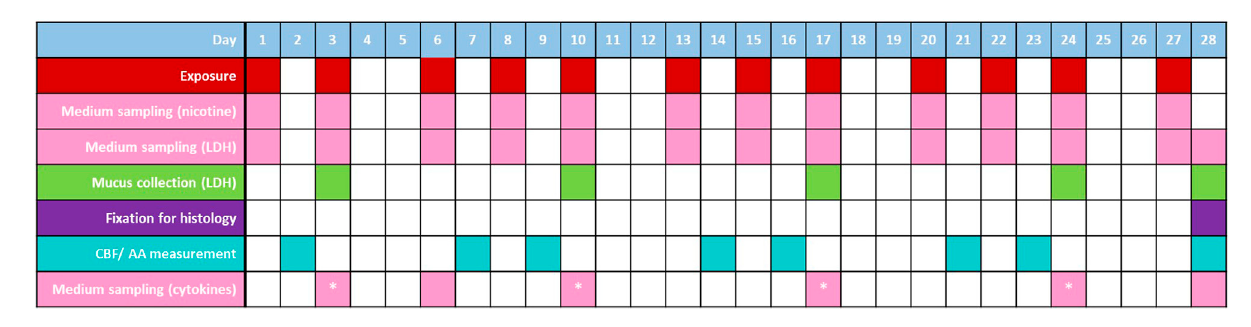
FIGURE 1 Exposure and sampling/measurement regimes for the 3D models over the experimental period. Samples of medium were taken (following exposures; prior to harvesting on day 28) and mucus (4 h prior to exposures) over the experimental period for LDH release measurement; medium was also sampled for cytokine analysis directly before exposure; on days denoted with *, samples were taken both directly before exposure and 4 h following exposure. Cilia beat frequency (CBF)/active area (AA) measurements were taken on days where exposure did not occur (these measurements were additionally taken on days − 5 and 0 to assess tissue functionality prior to the experimental period). Treatments of additionally allocated tissues with 5 ng/mL positive control, IL-13, werealsoincludedinthestudy(days13,15,17,20,22and24);cellsweretreatedwithCBFpositivecontrol,procaterolonday21(positivecontrolsnotincluded in this fi gure to increase readability). On day 28, a subset of tissues were fi xed for histological